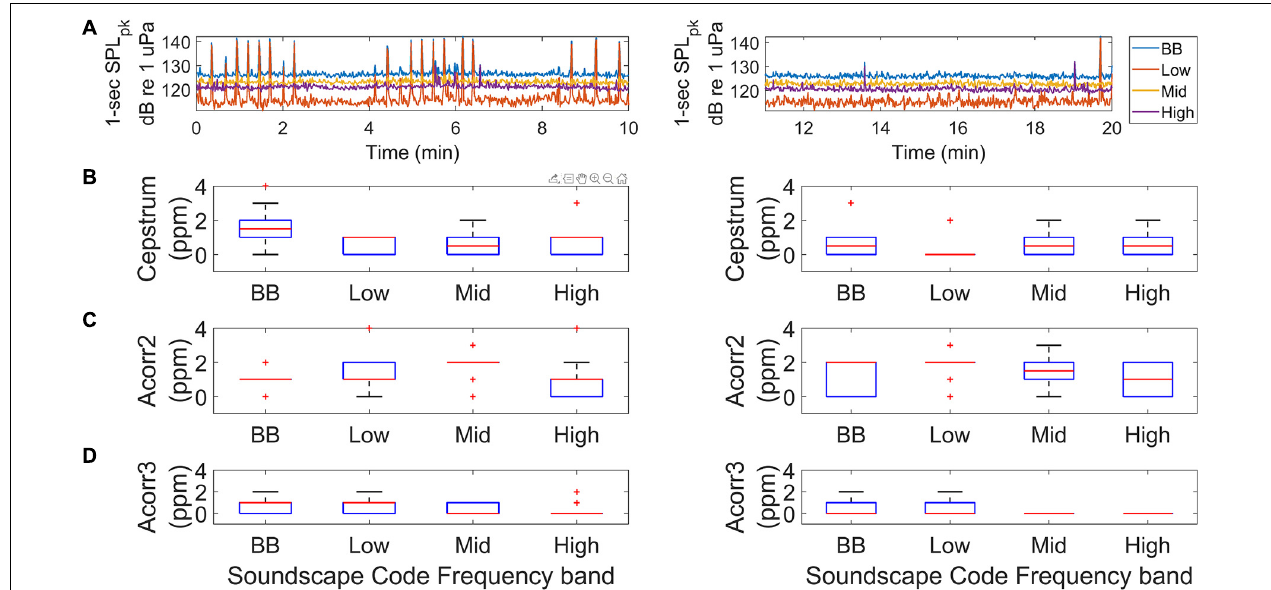
FIGURE 7 | Periodicity comparison P1 results. 20-Hz fin whale vocalizations captured in (A) frequency filtered 1-SPLpk for time window 1 (left) and time window 2 (right). Boxplots show range of periodicity candidate metric values (ppm) corresponding to the two time windows for (B) cepstrum, (C) acorr2, and (D) acorr3. The red horizontal line indicates the median value, outer edges of boxes represent 25 th and 75 th percentiles, whiskers mark the boundary that contains approximately 99% of data values, and the red points are